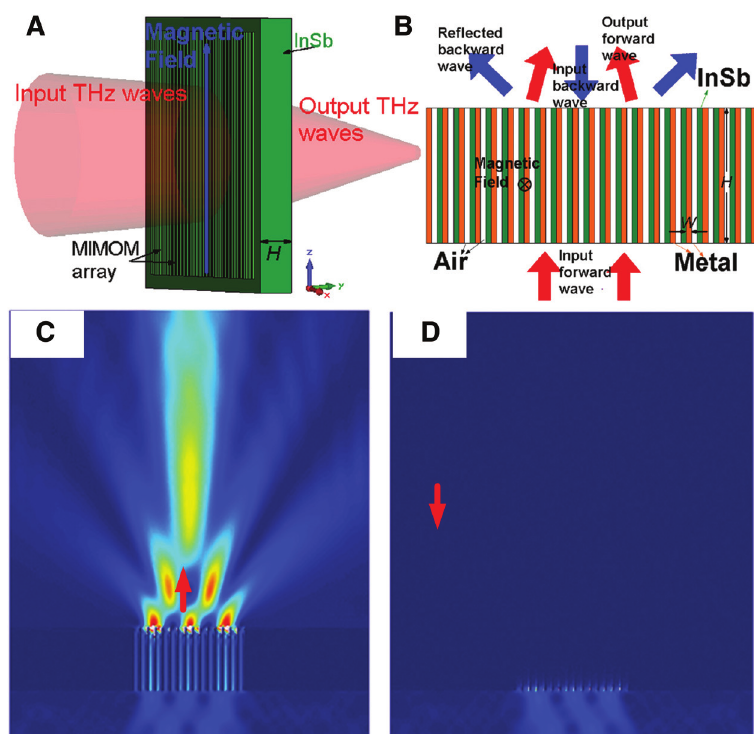
Figure 10: A one-way plasmonic slit lens (PSL) (from [79]). (A) and (B): Schematic structure of the lens. It consists of many asymmetric slot waveguide units. Each unit is composed of metal, air and InSb. (C) and (D): Forward and backward power flow distributions through the